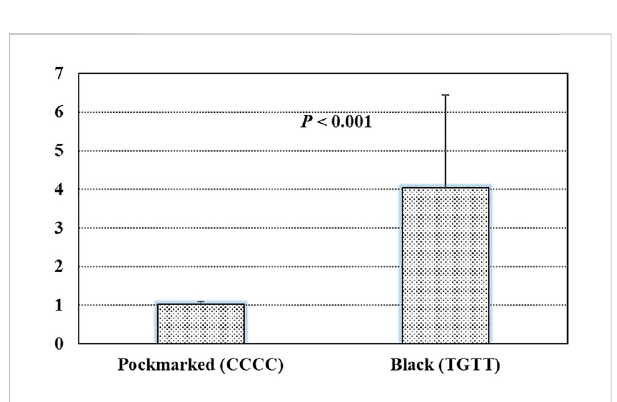
FIGURE 5 Results of real-time quantitative polymerase chain reaction in pockmarked ( n = 3, haplotype-CCCC) and black ( n = 3, haplotype- TGTT) feather bulb